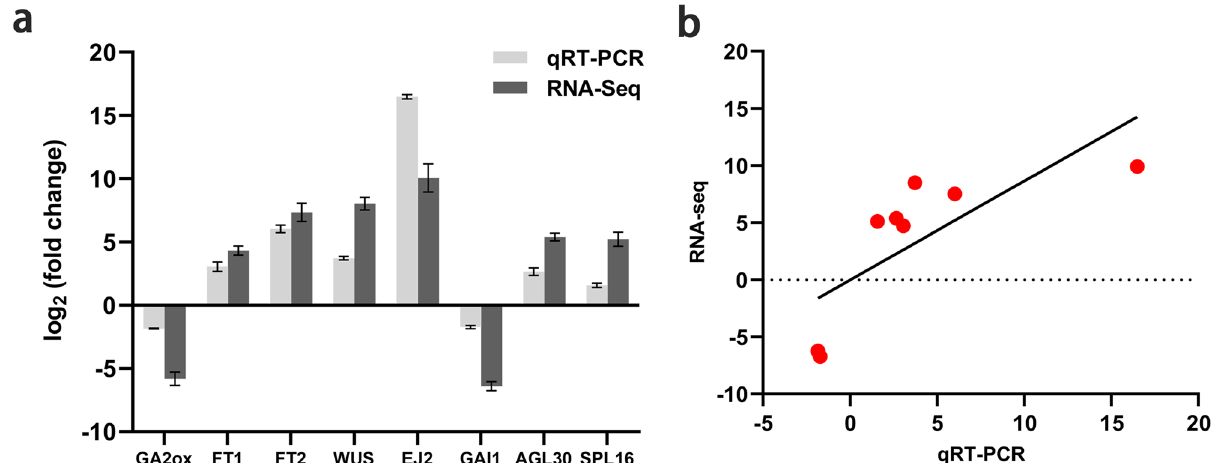
Figure 3. Verification of DEGs related to flowering and correlation analysis. ( a ) Verification of DEGs using qRT-PCR. The qPCR section was plotted with the expression of genes in leaf buds as a control and the relative expression of genes in flower buds, and the RNA-seq section was plotted with the leaf bud transcriptome as a control and the log2 (fold change) of genes. ( b ) Pearson correlation analysis of the expression of DEGs between qRT-PCR and RNA-Seq.